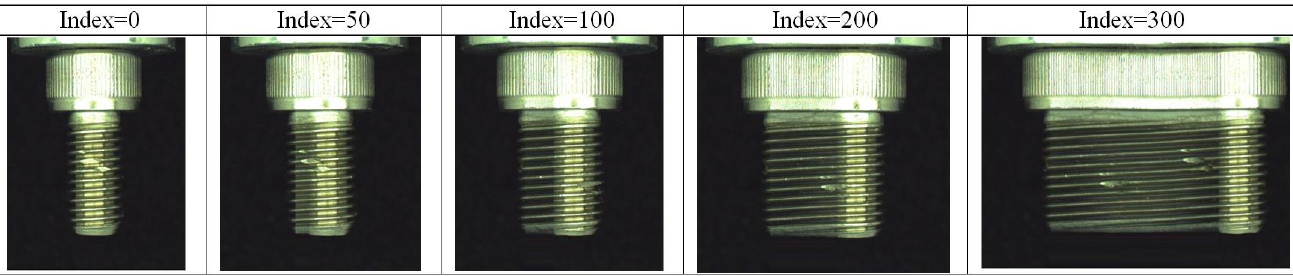
Figure 7. The process of merging multiple slices of screw images into a panoramic image (unit: 0.03 mm/pixel).